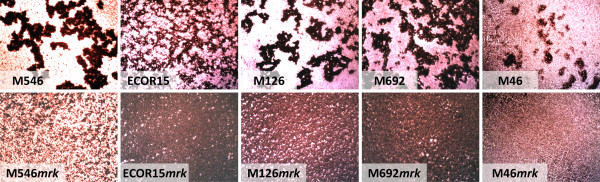
Phase contrast microscopy illustrating MR/K agglutination. Parental wild-type strains C. koseri M546, E. coli ECOR15, K. oxytoca M126, K. pneumoniae M692 and C. freundii M46 demonstrated strong agglutination of tannic acid treated human erythrocytes, while their corresponding mrk deletion mutants, M546mrk, ECOR15mrk, M126mrk, M692mrk and M46mrk were negative for agglutination.